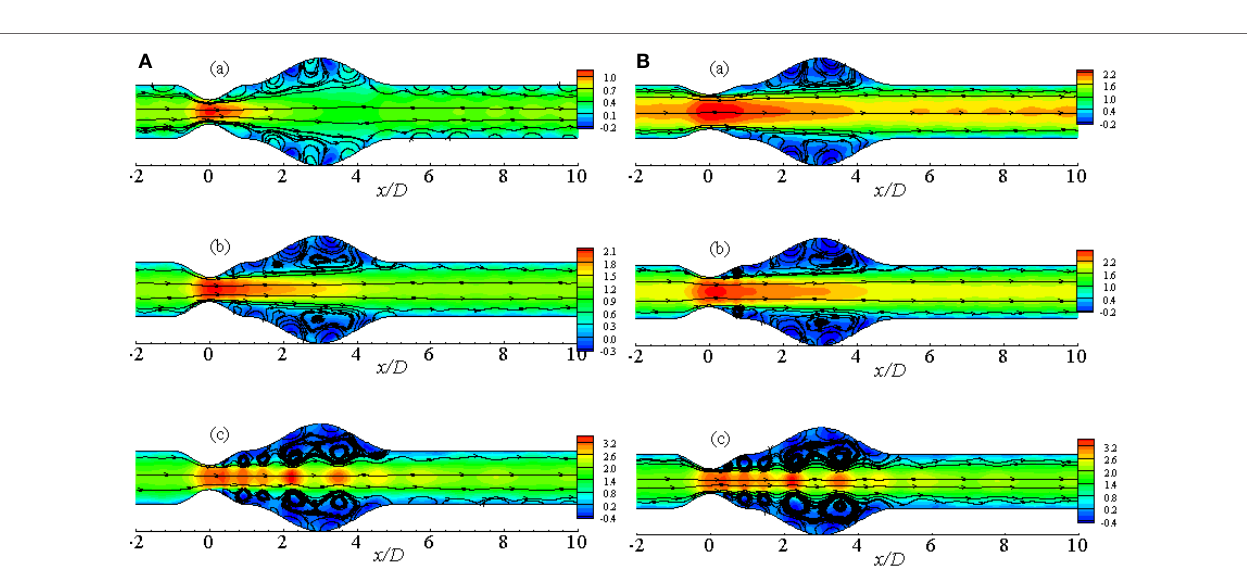
FIGURE 7 | Streamlines while aneurysm = 100% dilated and Re = 300 for (A) various Reynolds numbers, i.e., (a) Re = 100, (b) Re = 200, and (c) Re = 300 and (B) various percentage of stenosis, i.e., (a) 40, (b) 50, and (c) 60% for Cross model where the amplitude of wall oscillation, A = 3 (cid:2) 10 (cid:0) 4